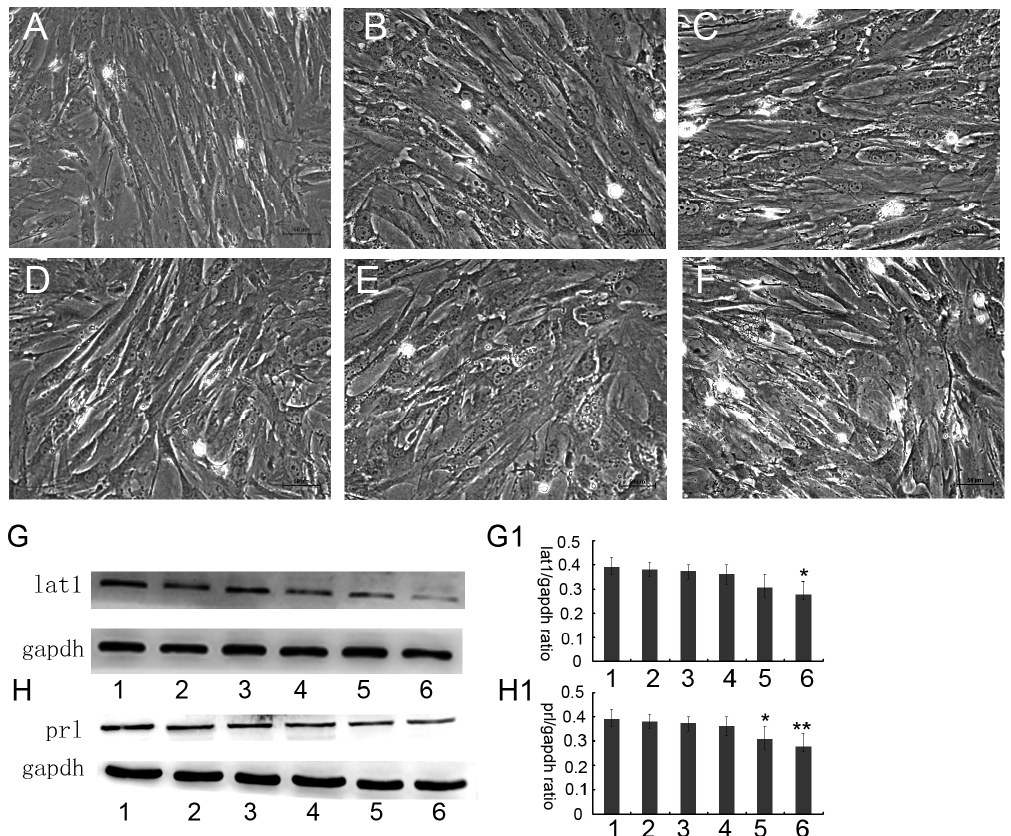
Figure 4. Effects of BCH on lat1 and prl expression in decidualization of ESC. Decidualizing ESC was treated with 0.05 µ M, 0.1 µ M, 0.5 µ M, 2 µ M, or 4 µ M BCH separately were analyzed by Western blot.